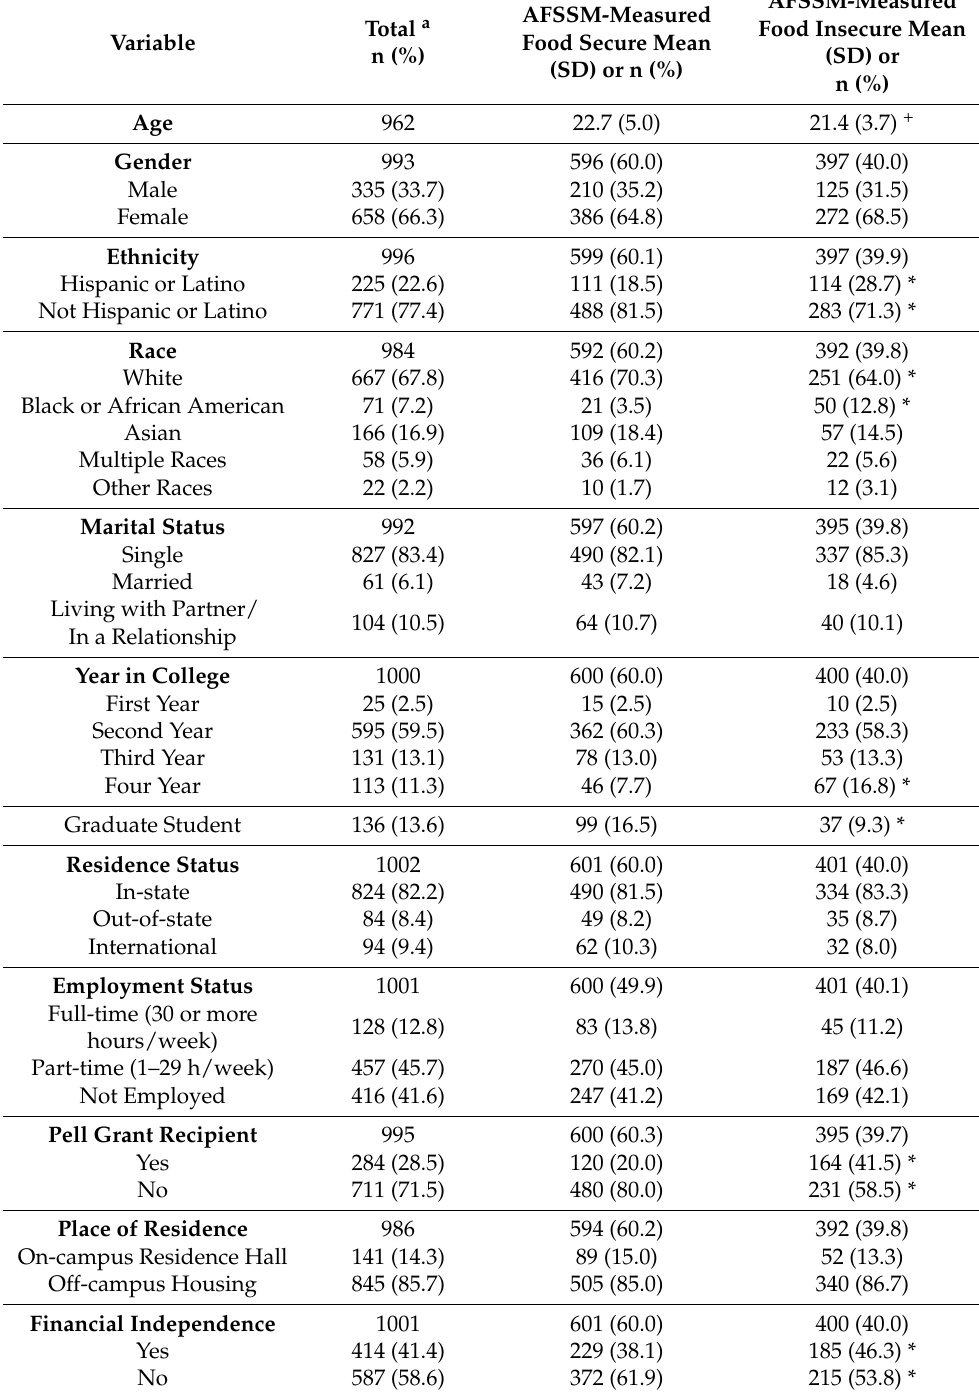
Table 1. Sociodemographic Characteristics of College Student Participants by AFSSM-Measured Food Security